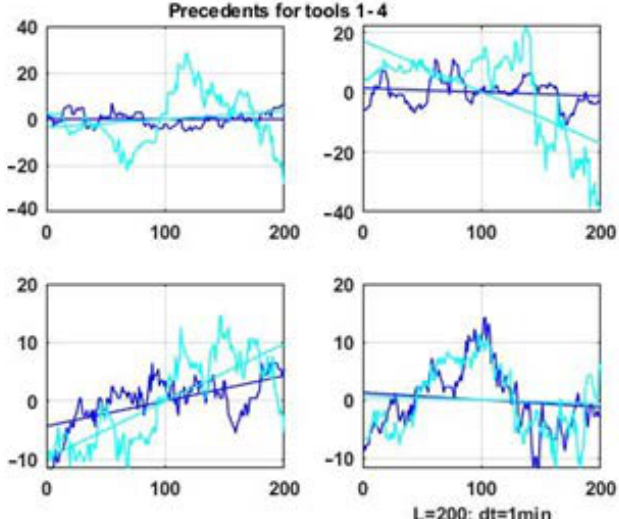
Figure 7. Precedent windows for four parameters of a multidimensional chaotic process by the Hotelling statistic.